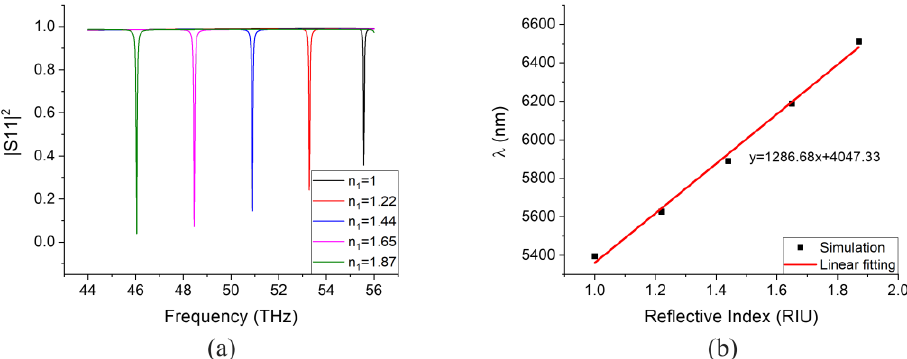
Figure 8. ( a ) Reflection coefficient for the device with infinite periodic structure and reflector working in the optical mode of operation with µ c = 1500 meV under large medium refractive index change. ( b ) Peak wavelength versus corresponding medium refractive index and its linear fitting.